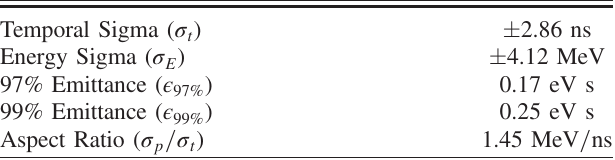
TABLE II. Gaussian fit parameters for longitudinal distribution measured by tomography.